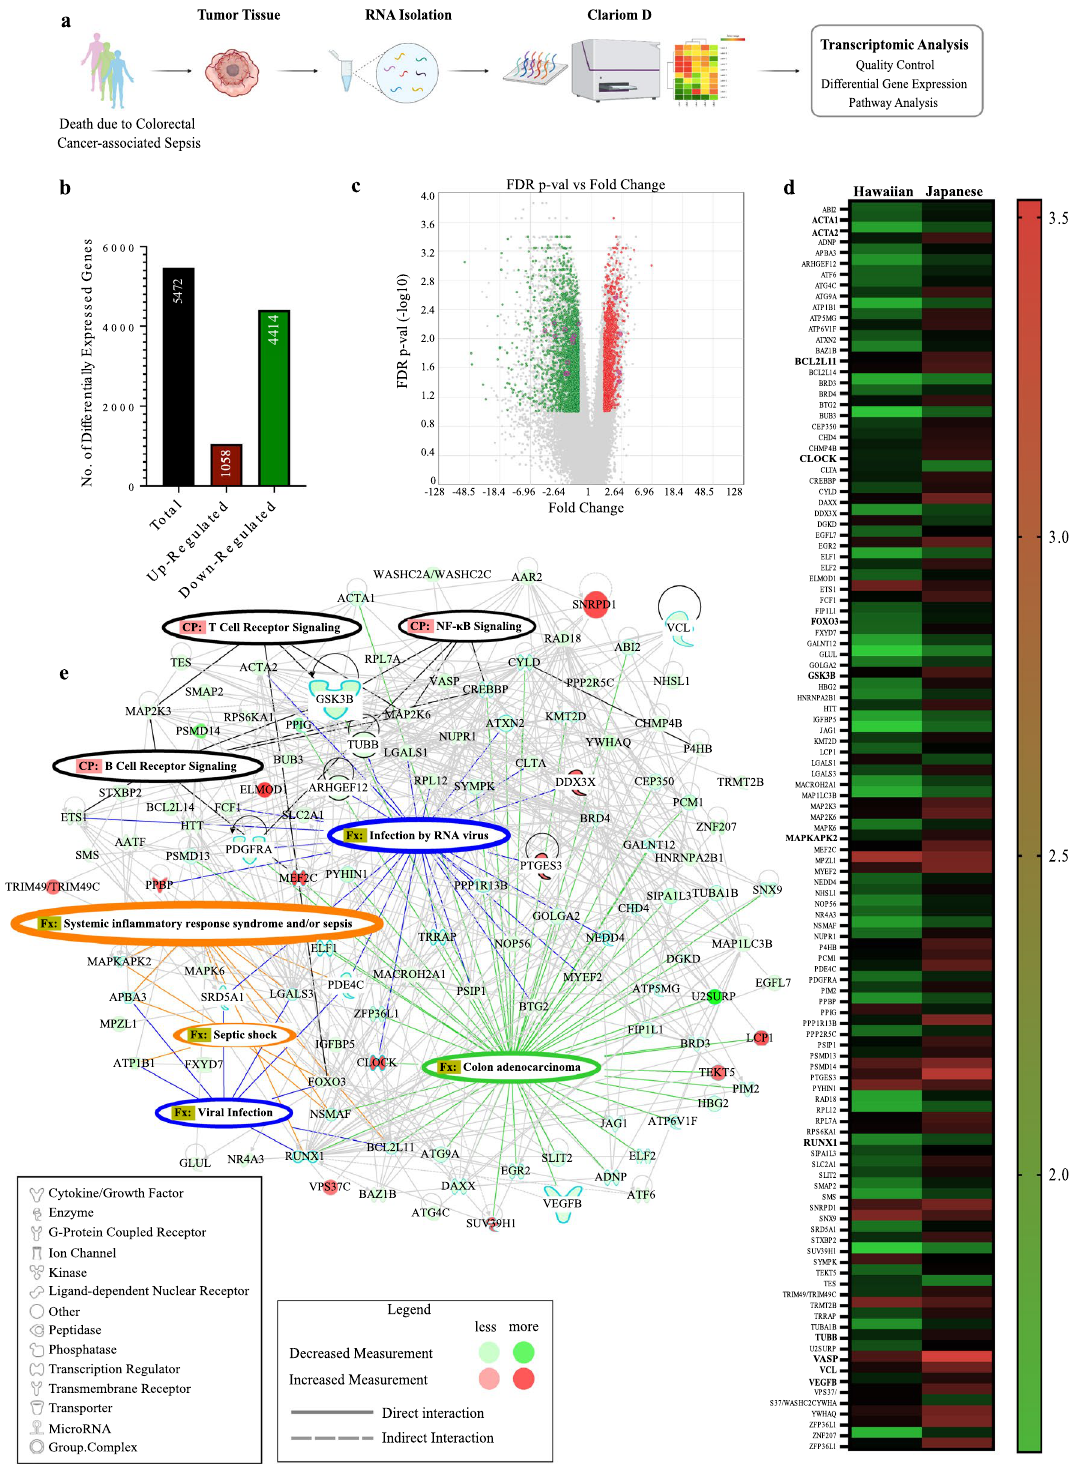
Figure 1. Transcriptome profiling of Native Hawaiian and Japanese colorectal cancer-associated sepsis samples. ( a ) Experimental design. ( b ) Number of total differentially expressed genes in Native Hawaiian samples compared to Japanese. ( c ) Volcano plot of differentially expressed genes for Native Hawaiians vs Japanese (red indicates upregulated genes, and green downregulated genes with a fold change of > 1.5, < − 1.5 and false discovery rate < 0.05). ( d ) Heatmap showing significant up- and down-regulated differentially expressed genes in Native Hawaiians compared to Japanese involved in sepsis, septic shock, viral infection and colon adenocarcinoma. ( e ) Network of most enriched genes from heatmap in ( d ) generated in IPA and their associated canonical pathways (CP). Legend describes log2(FPKM)